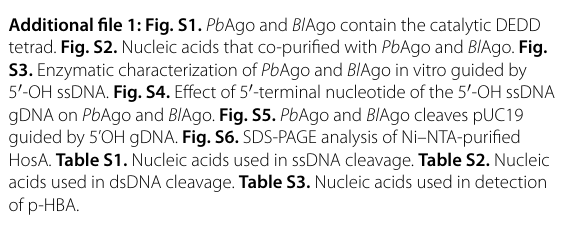
HosA. Table S1. Nucleic acids used in ssDNA cleavage. Table S2. Nucleic acids used in dsDNA cleavage. Table S3. Nucleic acids used in detection of